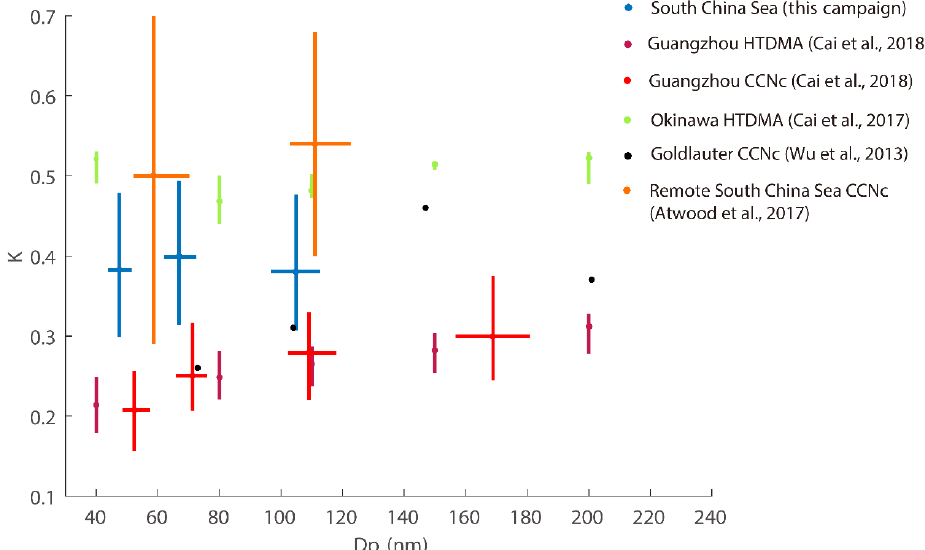
Figure 3. The median and interquartile κ values measured over the South China Sea, at an urban site in Guangzhou, and at a marine background site in Okinawa and the mean and SD κ values measured over the remote South China Sea and at mountain site in Goldlauter. The κ values over the South China Sea were obtained from CCNc measurements (ss = 0.18%, 0.34%, and 0.59%; in blue). The κ values in urban Guangzhou were obtained from CCNc (ss = 0.1%, 0.2%, 0.4% and 0.7%; in orange) and HTDMA measurements (in purple). The κ values in the marine region Okinawa were obtained from HTDMA measurements (in green). The κ values in the remote South China Sea were obtained from CCNc (ss = 0.14% and 0.38%; in orange). The κ values at the mountain site in Goldlauter were obtained from CCNc (ss = 0.07%, 0.10%, 0.19% and 0.38%; in